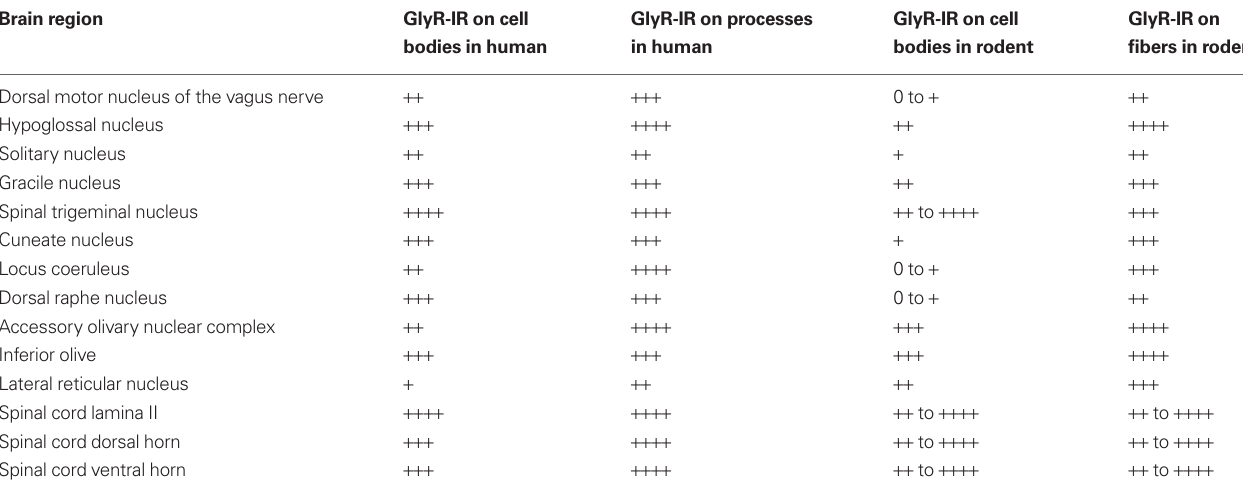
Table 2 | Comparison of the distribution of relative intensity of GlyR-IR in human and rodent brainstem and spinal cord (van den Pol and Gorcs, 1988; Rampon et al., 1996; Baer et al., 2003). Brain